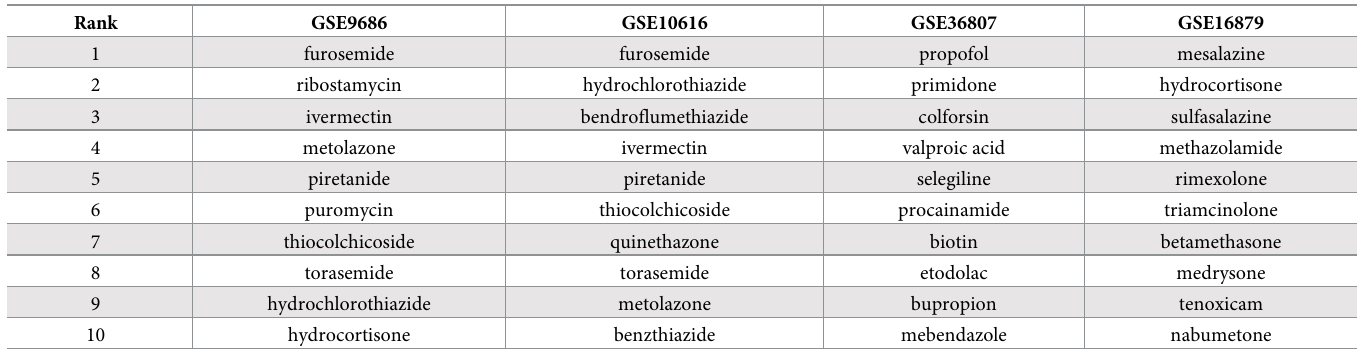
Table 1. Average drug rankings for each GEO study for CD samples.